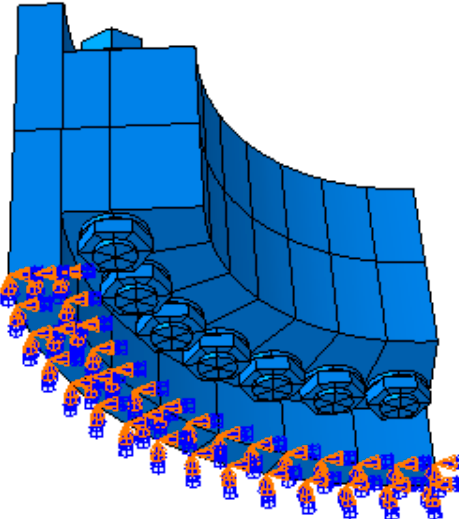
Figure 4. Boundary conditions in the FE model .